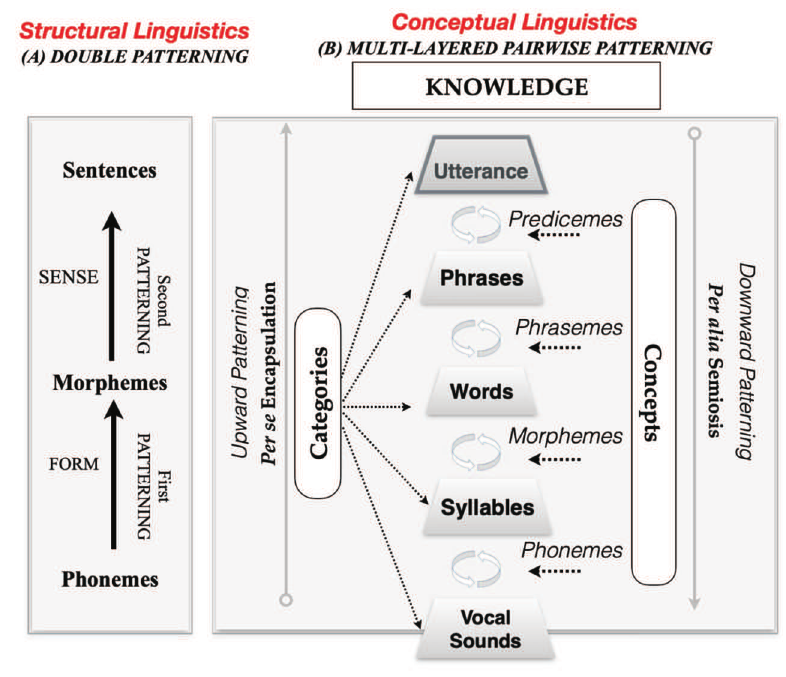
Figure 4. Essential Layers of Utterance Construction Architecture: (A) Double Patterning theory vs. (B) Multi-Layered Pairwise Patterning